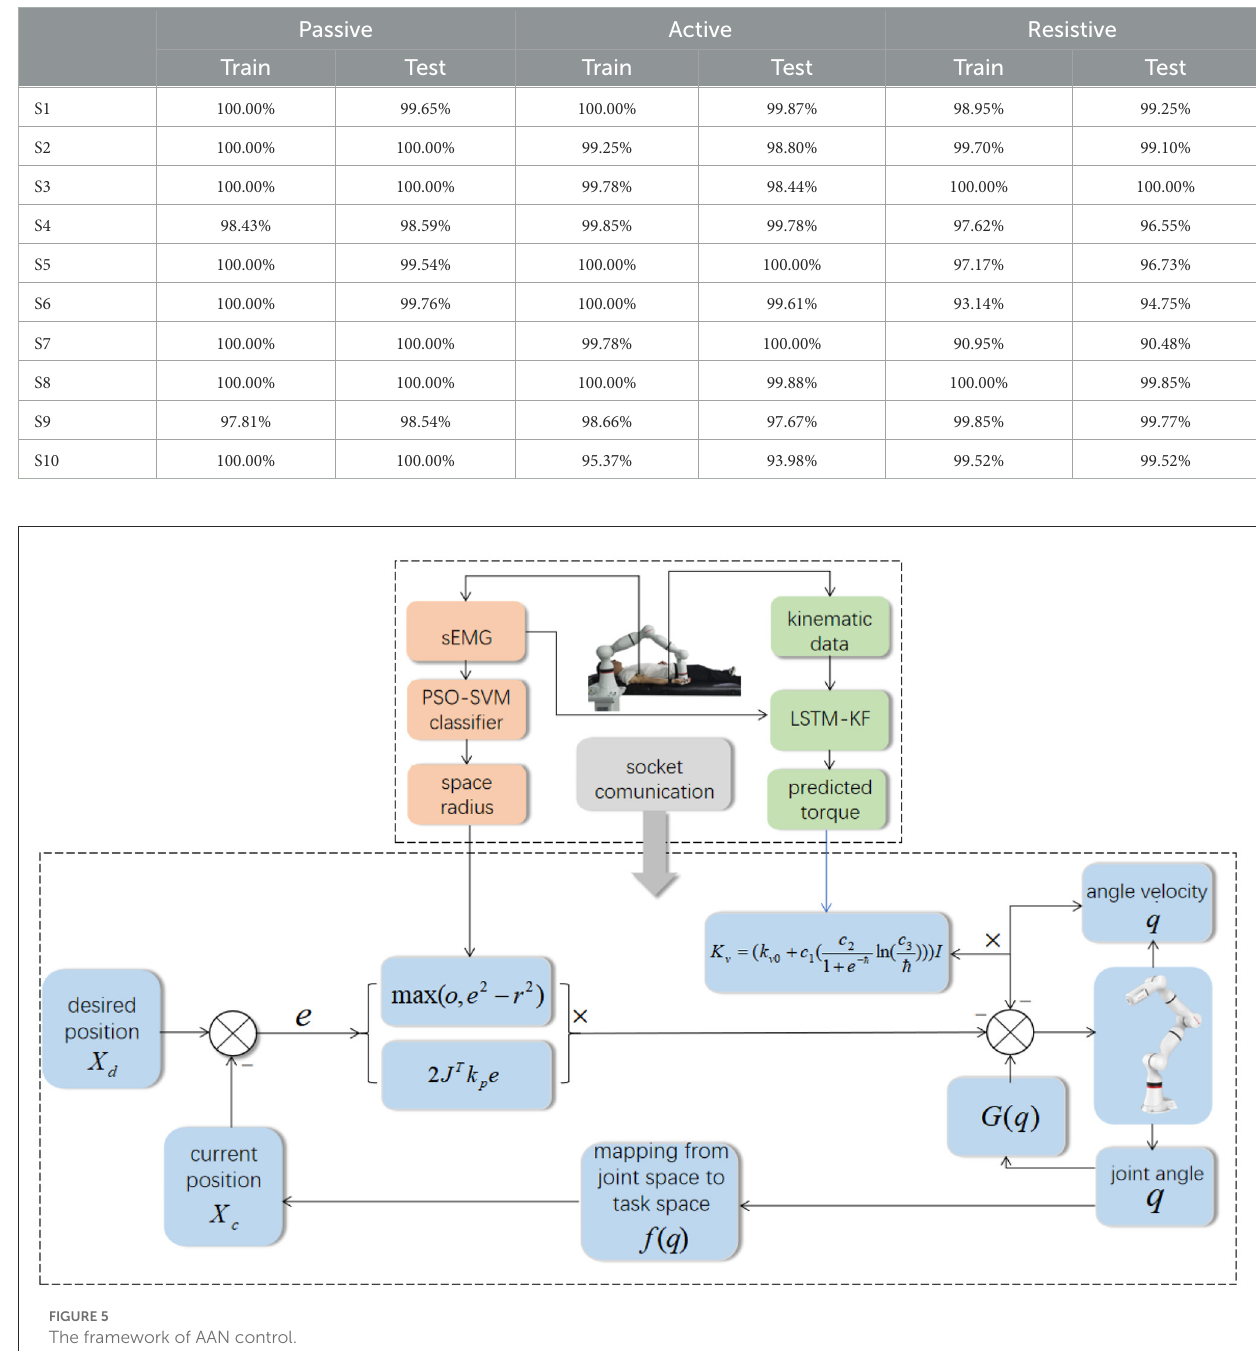
FIGURE5 The framework of AAN